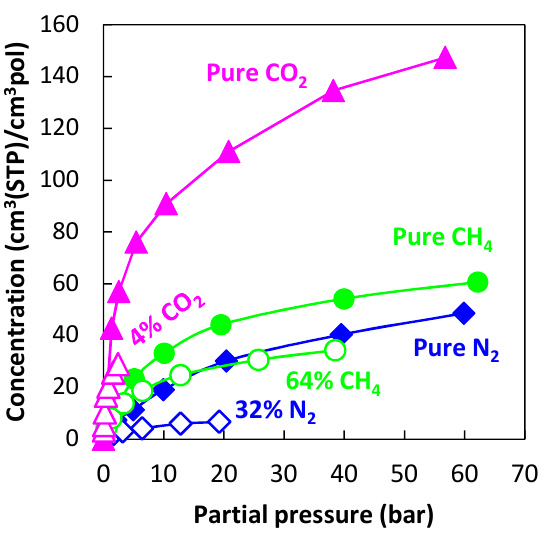
Figure 25. Simulated pure- and mixed-gas sorption (4:32:64 CO 2 /N 2 /CH 4 ) in 6FDA-6FpDA. Results from Neyertz and Brown [403].